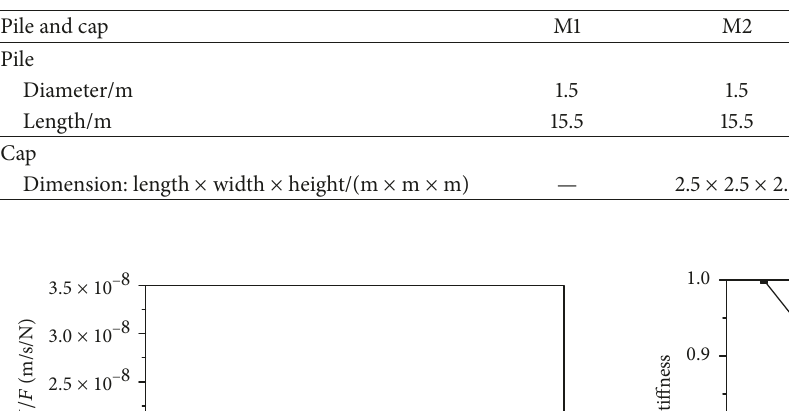
Table 2: The pile and cap dimensions of the four FE models.